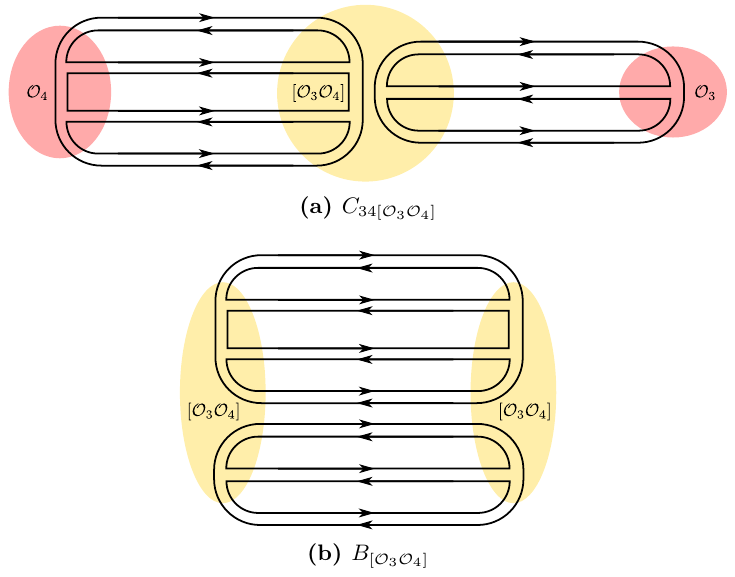
Figure 2. Diagrams showing the correlation functions that effectively reduce to products of two- point functions of the type shown in figure 1. Single-trace operators are shaded in red while double-trace operators are shaded in yellow. We have not attempted to distinguish between the different R-symmetry representations that [ O ] can have in the diagram. The main technical 3 O 4 challenge of this subsection is that each one leads to derivatives being distributed in different